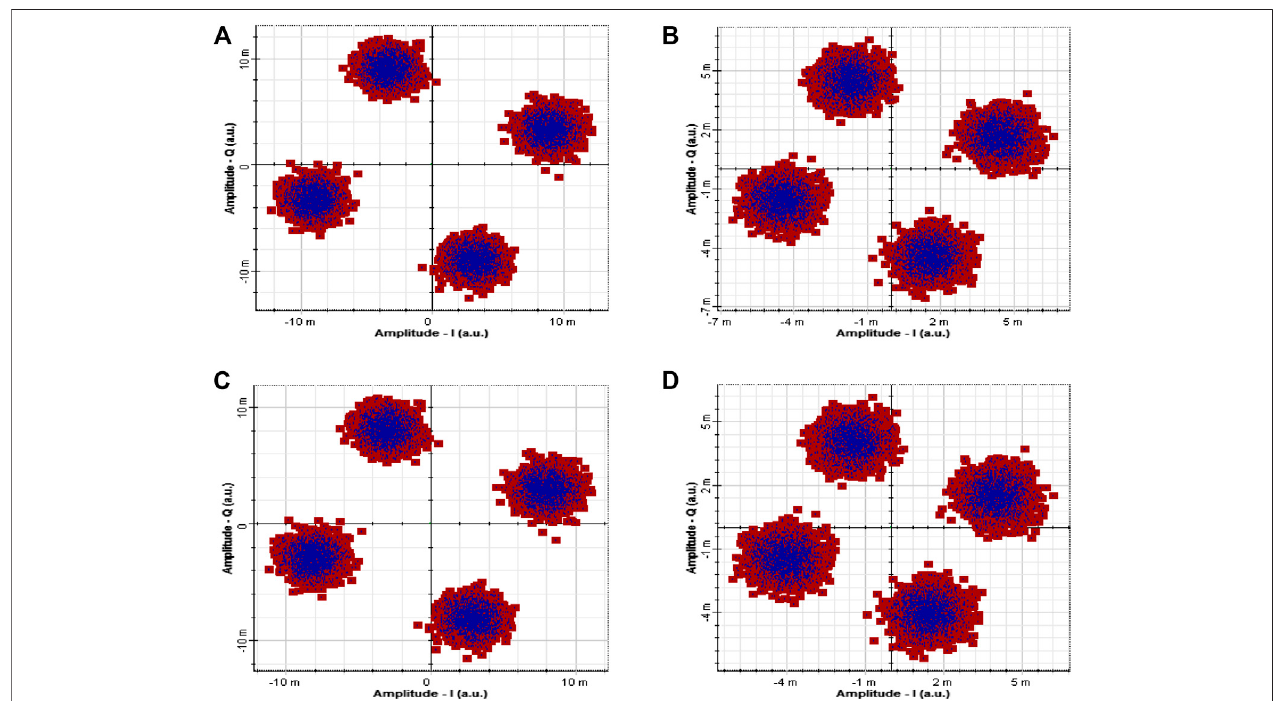
FIGURE 6 | Constellation plots after 32 km range for 193.1 THz channel (A) HG01 mode and (B) HG03 mode; for 193.2 THz channel (C) HG01 mode and (D) HG03 mode.